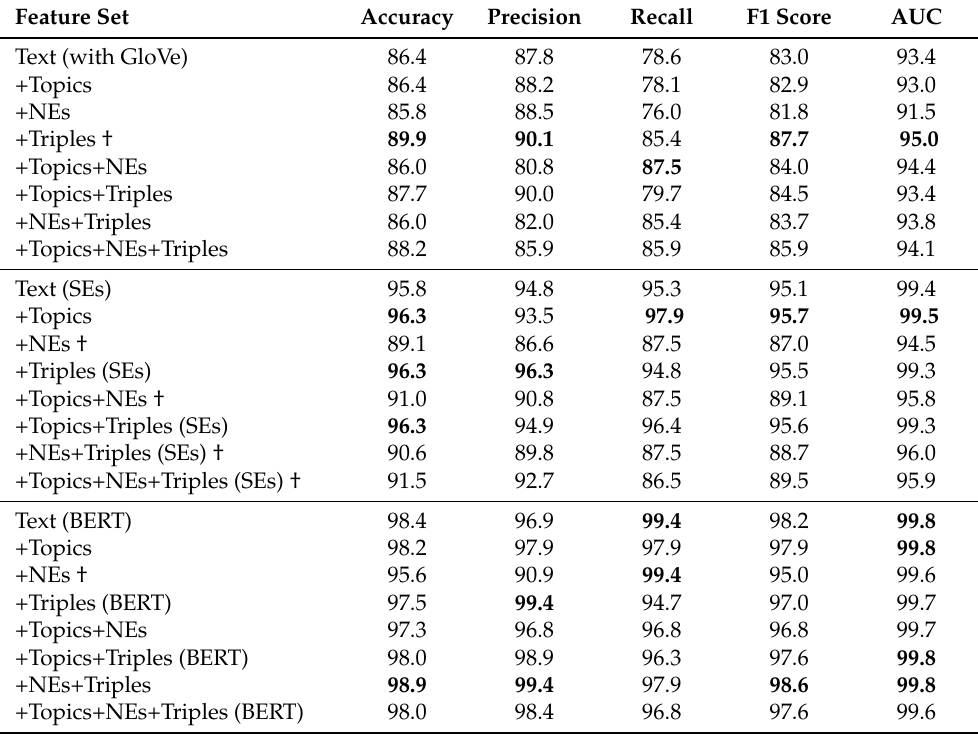
Table 3. News-feed classification results on the Reuters dataset. †s indicate statistically significant differences (using McNemar’s test) with reference to the baseline models. Note: SEs = Sentence embeddings, NEs = Named